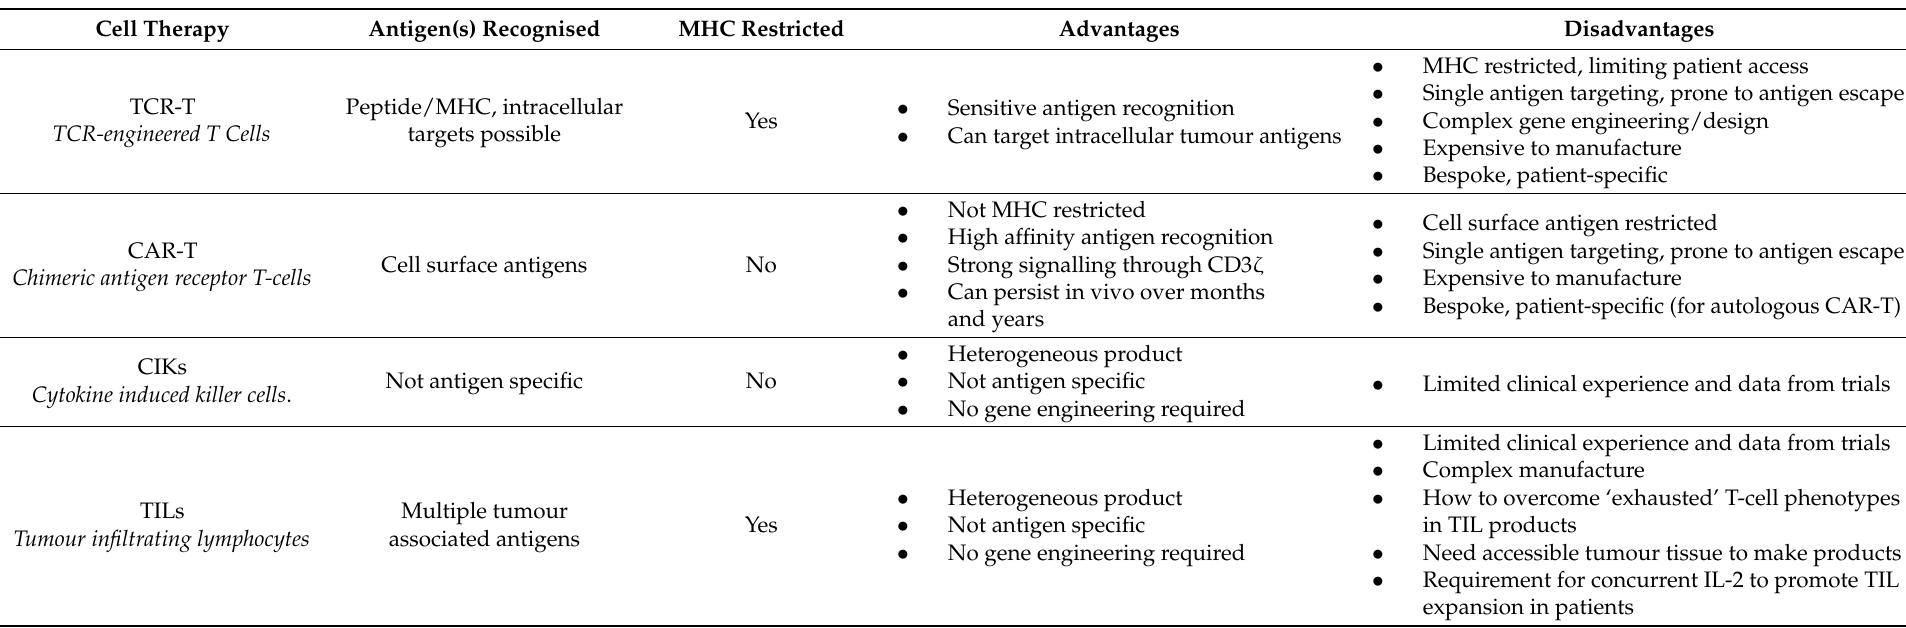
Table 3. Outline and comparison of the 4 main types of cellular therapies key